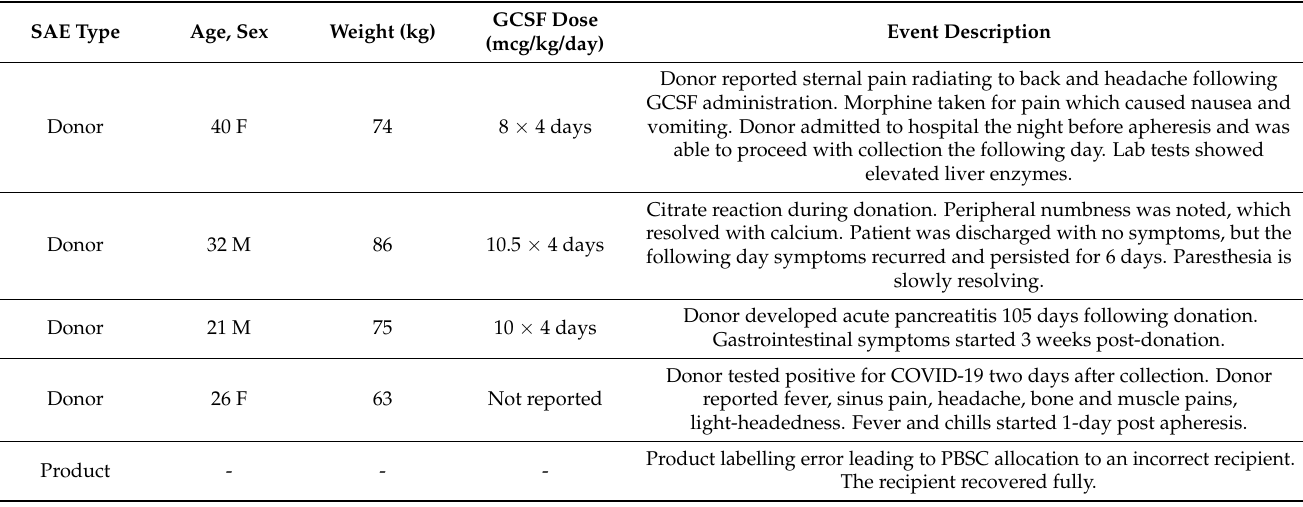
Table 3. Donor or Product Severe Adverse